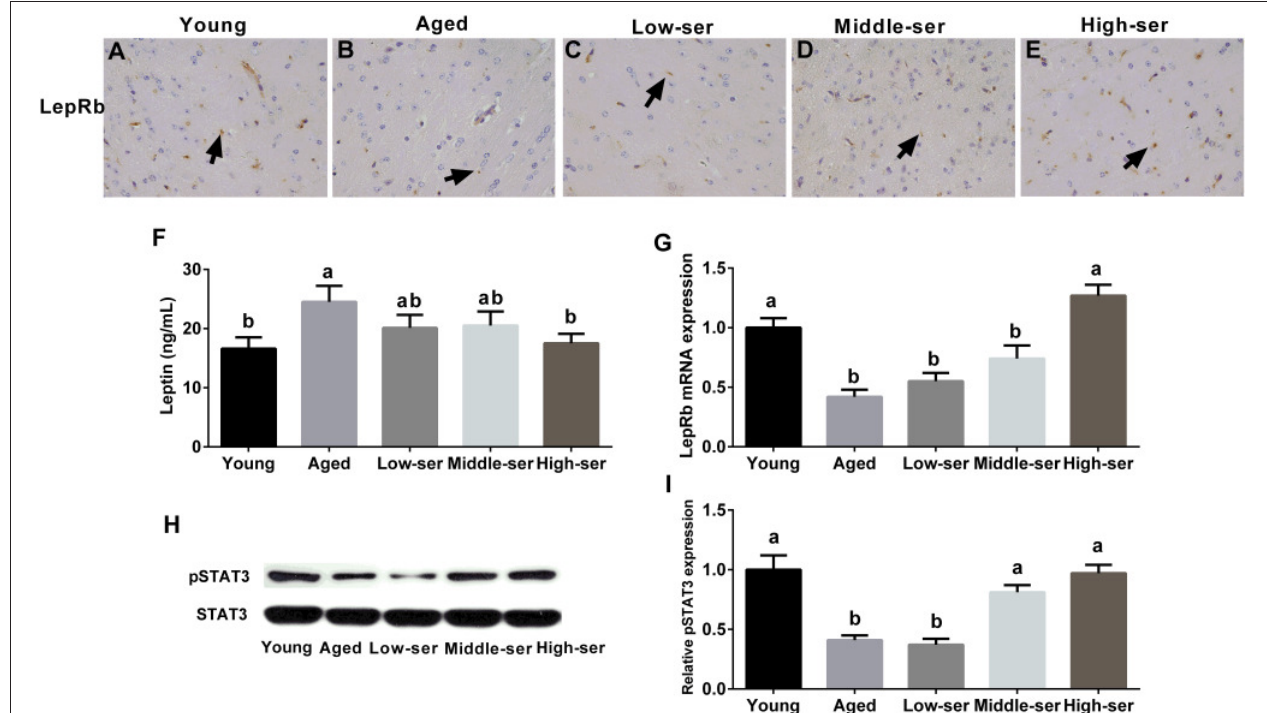
FIGURE 6 | Effects of long-term L -serine administration on the leptin signaling pathway in aging mice. (A–E) LepRb expression as determined by immunohistochemistry; (F) leptin content in the hypothalamus; (G) relative LepRb mRNA expression; (H,I) relative pSTAT3 protein expression. Aged, untreated control mice; Low-ser, mice fed with 0.1% (wt/vol) L -serine dissolved in the drinking water; Middle-ser, mice fed with 0.2% (wt/vol) L -serine dissolved in the drinking water; High-ser, mice fed with 0.5% (wt/vol) L -serine dissolved in the drinking water. Young, adult male mice at the age of 18 months. Arrow (yellow), expression of LepRb protein; LepRb, leptin receptor. Values are expressed as mean ± SEM, n = 3 for the statistical analysis of western blotting data and n = 8 for the statistical analysis of other data; a,b Means of the bars with different letters were significantly different among groups ( p <